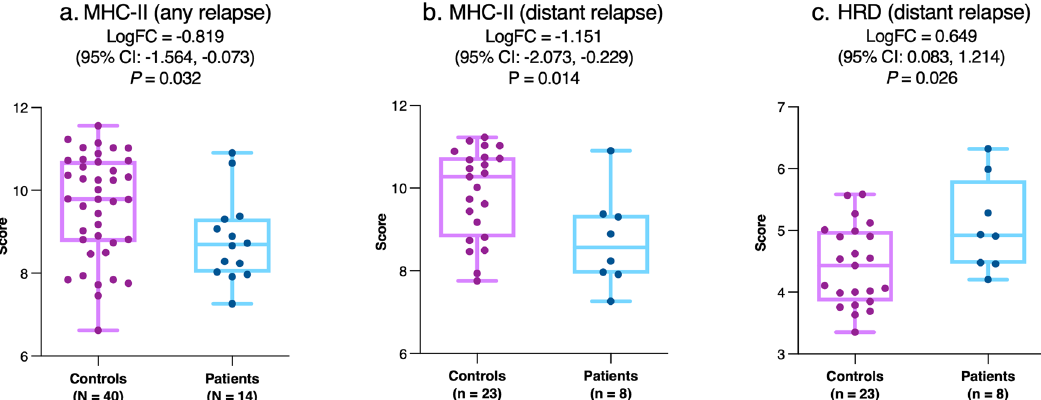
Fig. 3 Interindividual comparison of primary tumor gene expression between patients with relapse despite pCR and controls with pCR and no relapse. Data are shown for MHC-II ( a , b ) and HRD ( c ) signature expression for the overall cohort ( a ) and for the distant relapse subgroup ( b , c ). The central line indicates the median, the box indicates the 25th and 75th percentiles and the whiskers indicate the range. Circles represent individual data points. Negative values for logFC indicate lower expression in patients with relapse versus controls.